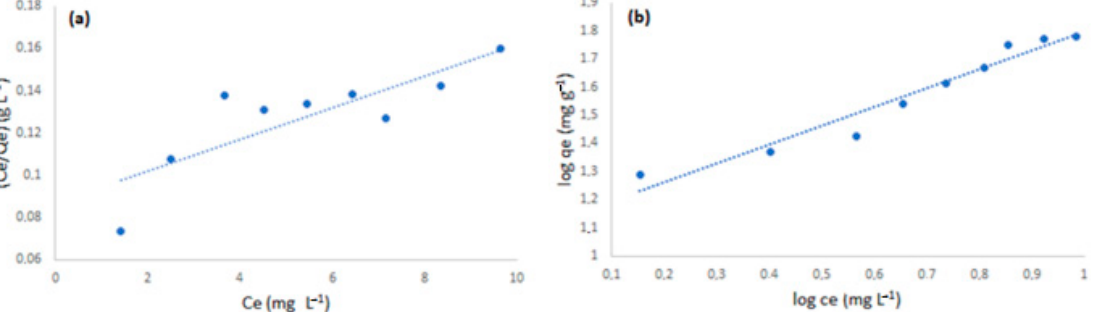
Table 1. Parameters for adsorption of malachite green to polyimide nanofiber.